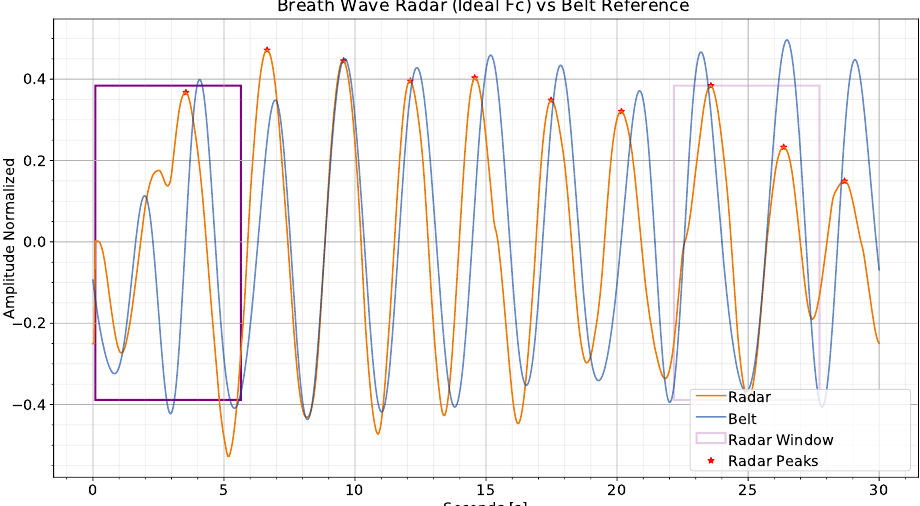
Figure 8. Example of sliding window generation for instant bpm estimation on a recorded session The radar signal has been filtered using the ideal belt, Fc . The radar, as opposed to the belt, is not connected to the user during recordings, but to the desk. This results in the local shift of signal breathing peaks due to the millimeter movements of the user. The window (in purple in the plot) is shown paler on the two peaks closest to the calculated peaks’ mean distance. It is also possible to notice some slight corruption at the beginning of the session due to user motion.